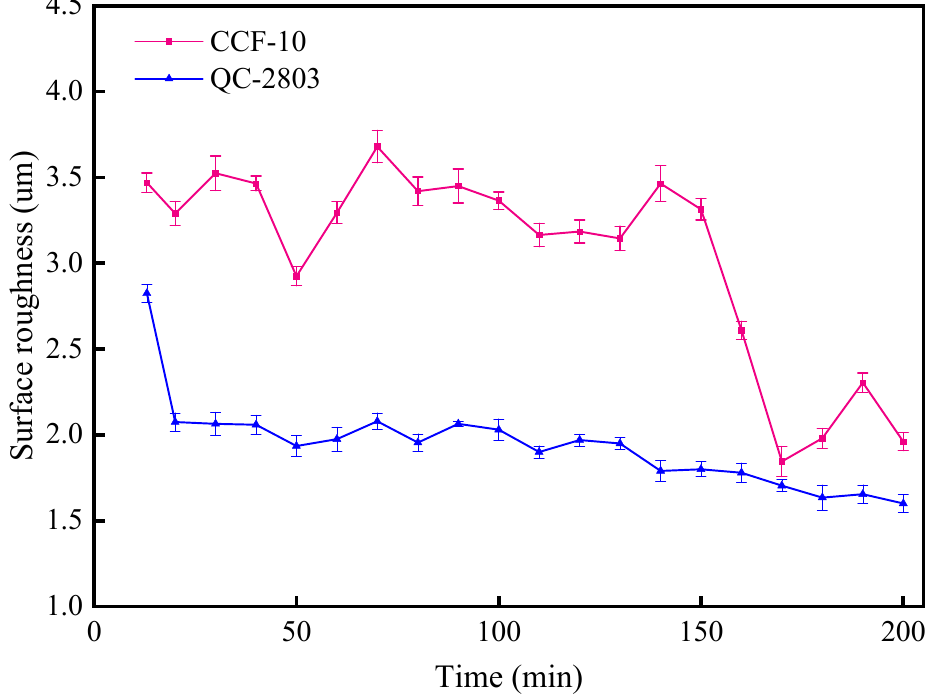
Figure 6. Surface roughness of CCF-10 and QC-2803.